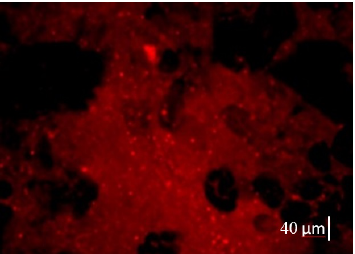
Fig. 4. Color spread of red zebrafish body muscle protein under fluorescence microscope (TxRed control